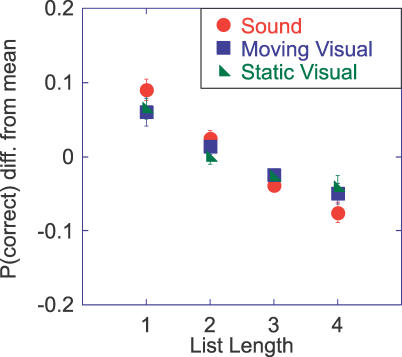
Effect of Length of the Study ListDifference from mean proportion correct responses (P(correct) diff) is plotted as a function of length of the study list. Statistics show a significant effect of stimulus type and list length, but no interaction between them. The mean proportions correct subtracted for each stimulus type were: sound, 0.72; moving visual, 0.61; and stationary visual, 0.59.